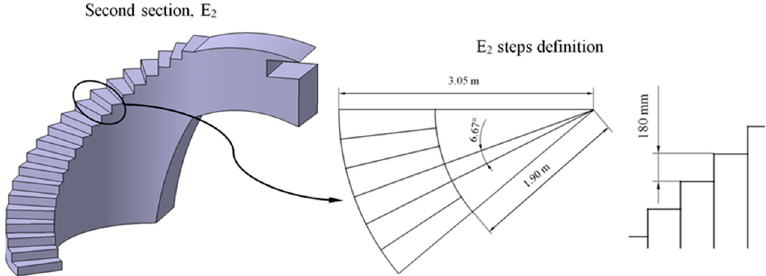
Figure 11. Definition of the steps for the second section of the E 2 construction element.